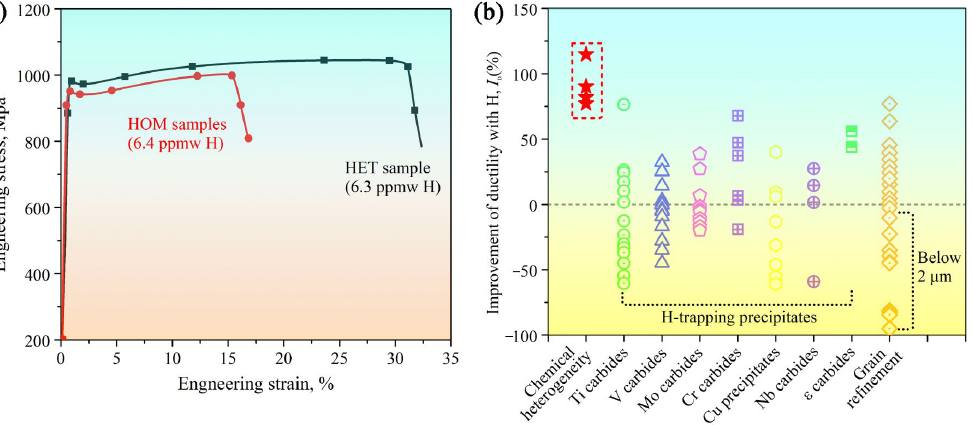
Figure 13. Improvement in the resistance to H embrittlement via designing chemical heterogeneity [111]. ( a ) Slow-strain-rate tensile properties. ( b ) Comparison between our approach and other H-resistance enhancing methods. This figure is reproduced based on [111].